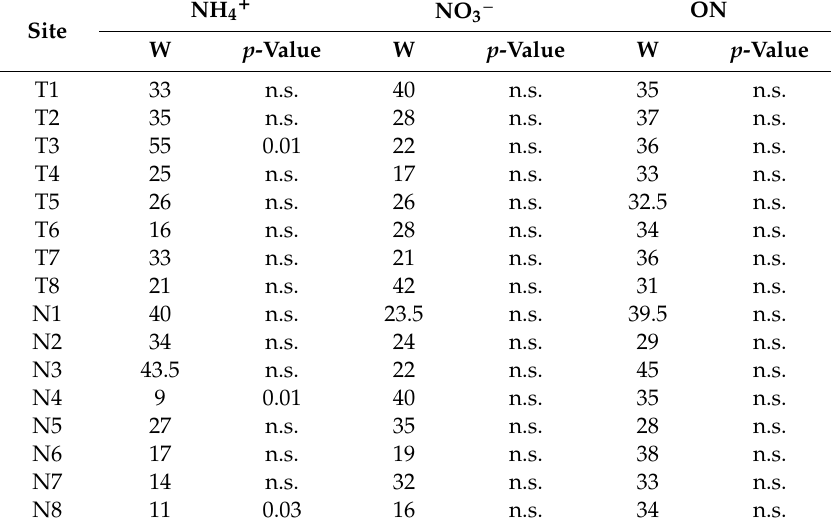
Table 2. Wilcoxon W test results testing the di ff erences in ammonium (NH 4 + ), nitrate (NO 3 − ) and organic nitrogen (ON) between the dry and the wet season. p -values are shown only for significant di ff erences ( p -value < 0.05) and reported as n.s. (not significant) when p -value > 0.05. NH 4 + NO 3 − ON Site W p -Value W p -Value W p -Value T1